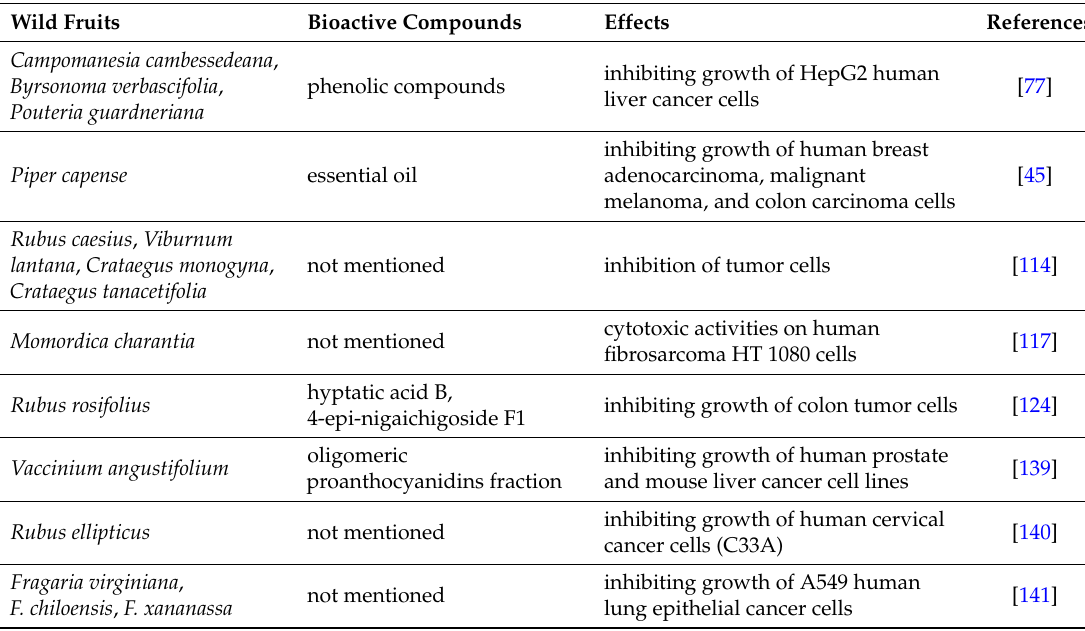
Table 4. Anticancer activities of some wild